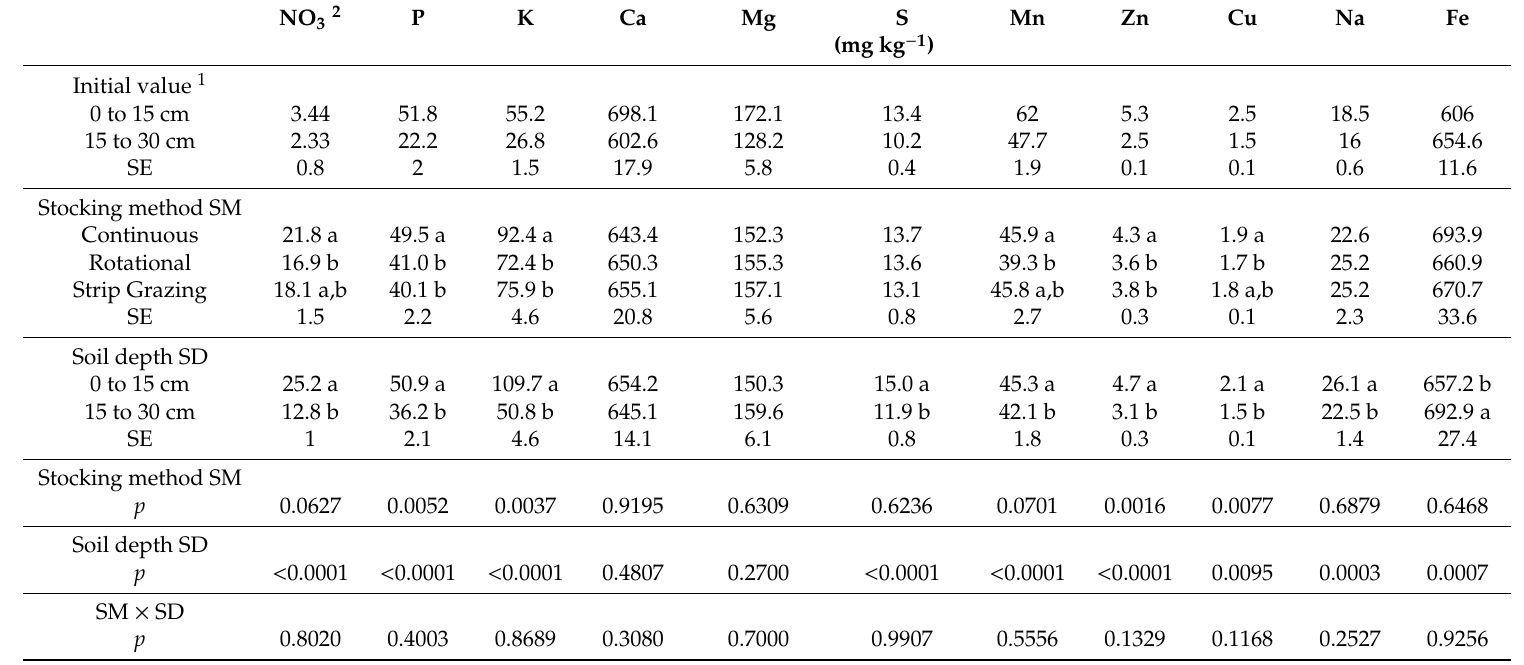
Table 3. Soil nutrients in tall fescue paddocks managed with growing-finishing pigs during two twelve-week grazing periods. NO 3